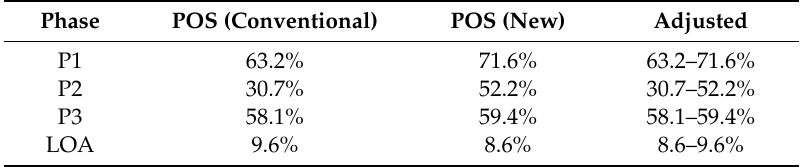
Table 16. Refined POS scope by NDA development phase for the whole period